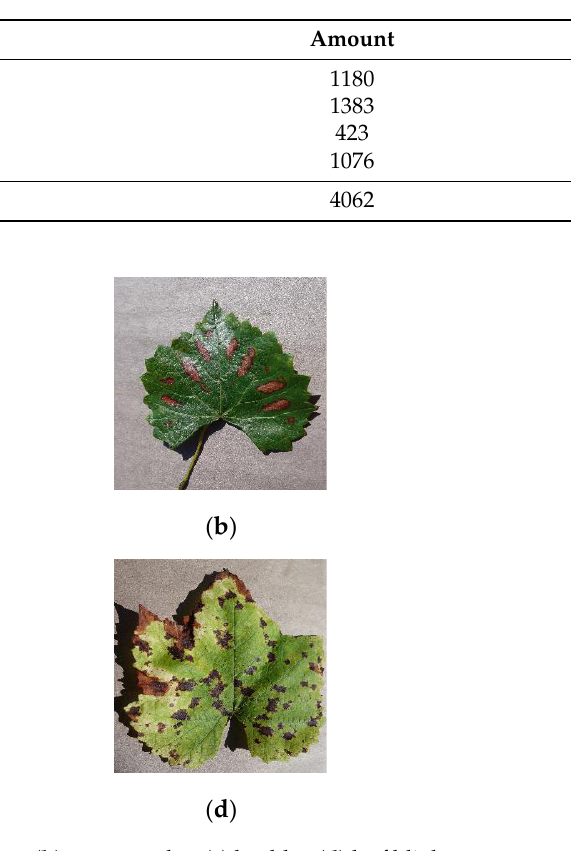
Figure 1. Grape leaf dataset: ( a ) black rot, ( b ) esca measles, ( c ) healthy, ( d ) leaf blight.